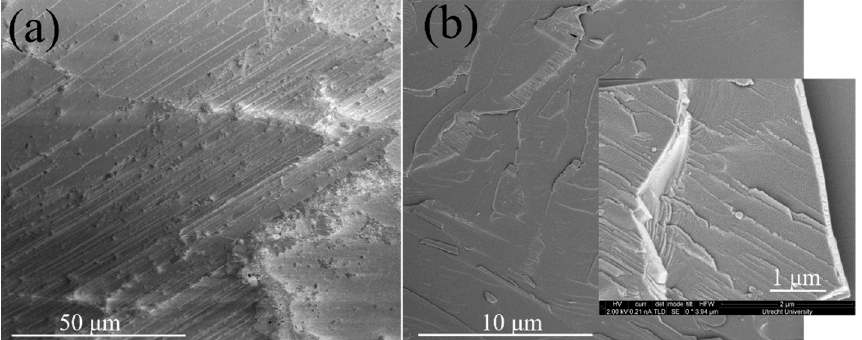
Figure 6. Exposed cleaved surfaces from SEM investigations on the slip surface of Carrara marble after 1.5 mm of slip. ( a ) River lines prevalent in the vicinity of the slip surface along cleavage, see also Figure 2b; ( b ) steps on the fracture surface between cleavage on parallel planes often indicated as resulting from intersection between cleavage fractures and moving dislocations [72]. The detail in the insert shows the splitting of a crack to form steps onto separate surfaces expanding past each other and then curving under the effect of mode II or mode III component in the stress field [71].